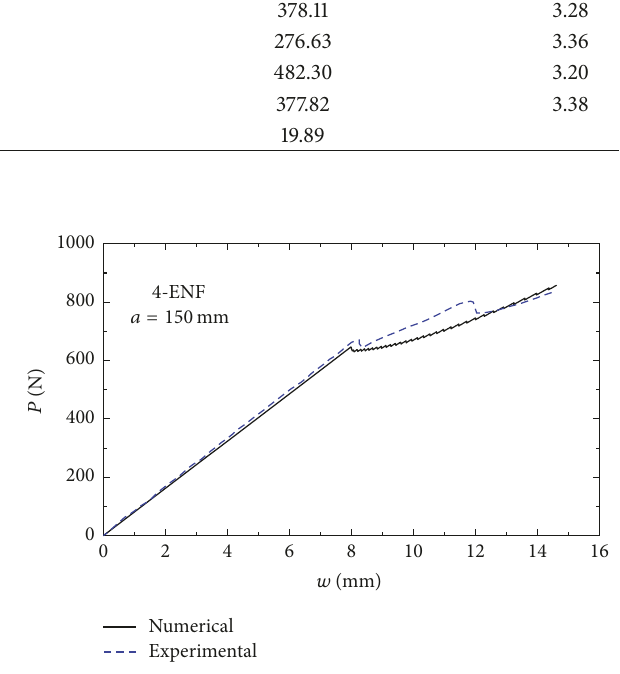
Figure 7: Comparison of numerical solution and experimental result for crack